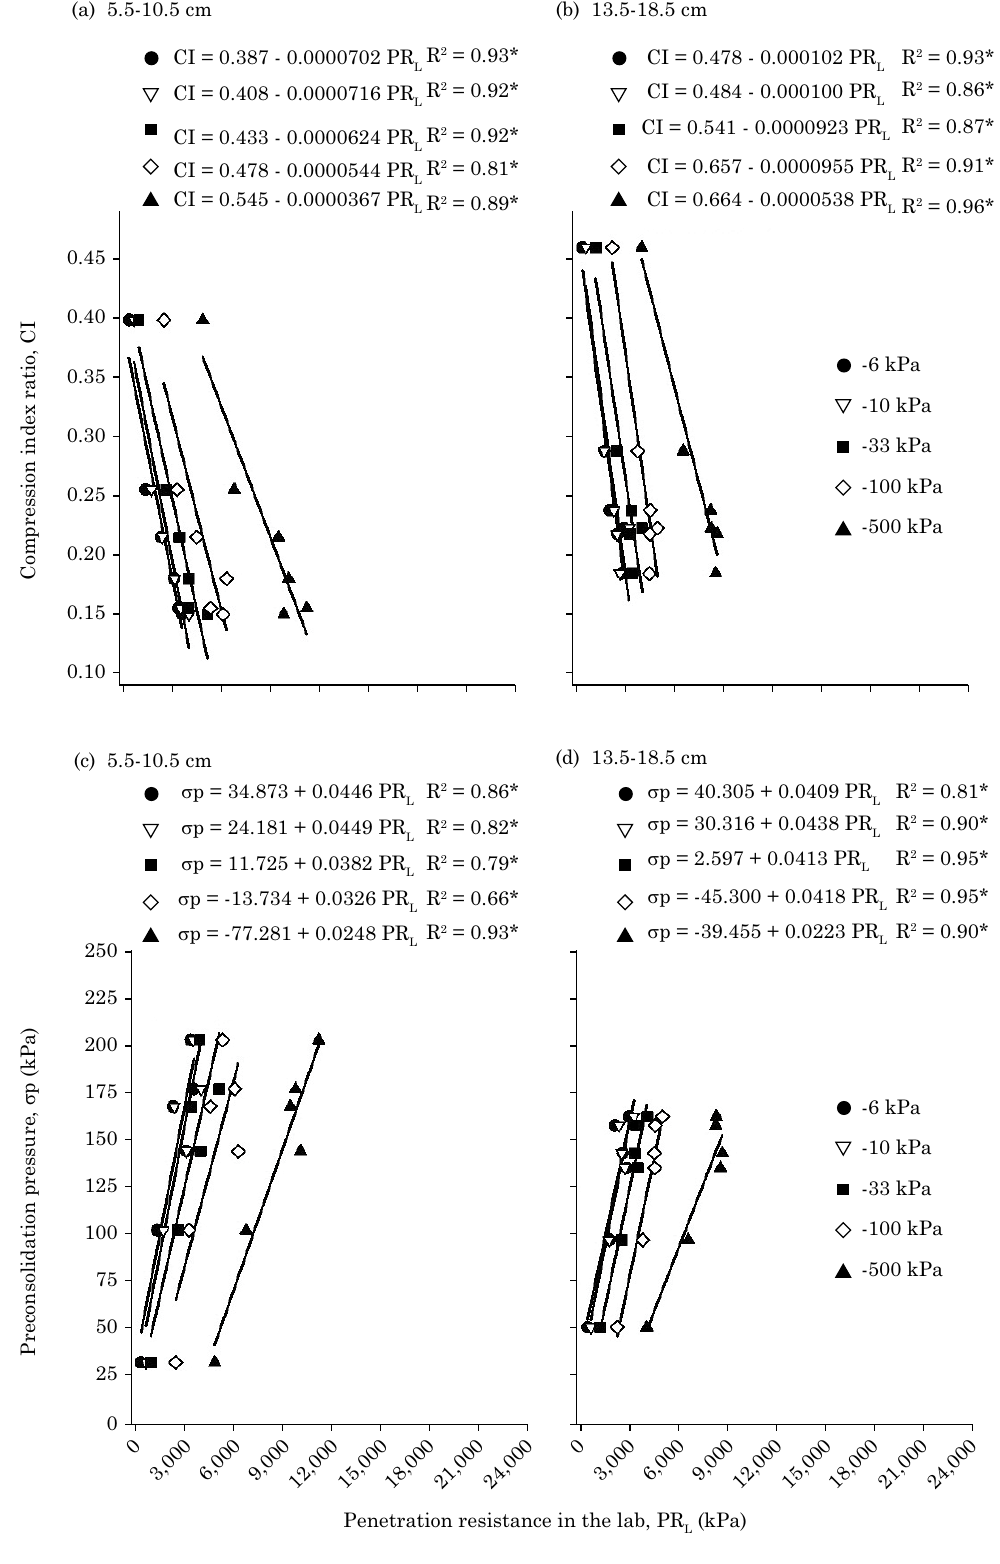
Figure 5. Compression index ratio - CI (a, b) and preconsolidation pressure - σp (c, d) with the soil mechanical resistance to penetration of a Rhodic Eutrudox measured with a static penetrometer (pr l ) at different soil water potentials, in the 5.5-10.5 and 13.5-18.5 cm